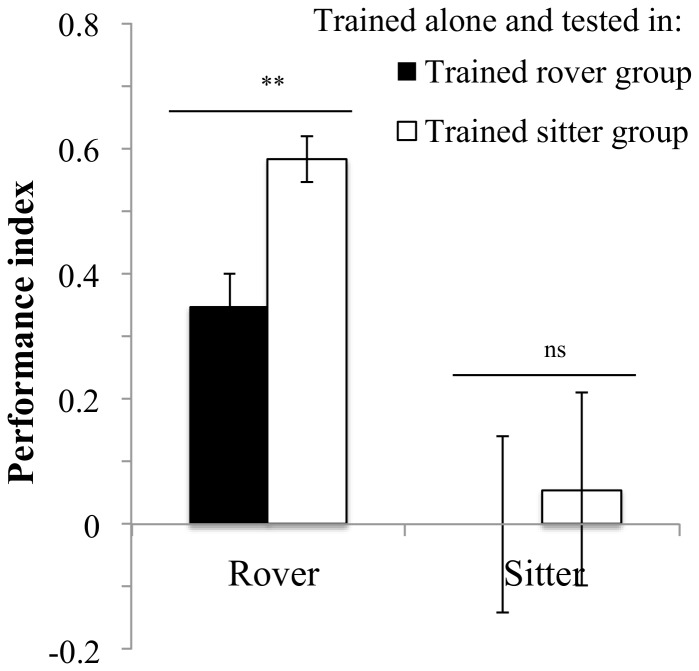
Effects of group composition during testing.Flies were individually trained and then tested within a trained group of the same strain or a different strain. Rover: in rover: PI = 0.34±0.05 N = 7 PI; in sitter: PI = 0.58±0.03 N = 6 PI. Sitter: in sitter: PI = 0.05±0.15 N = 6 PI; in rover: PI = 0±0.14 N = 7 PI. Error bars represent ±SEM. Comparison between treatments. ns: P>0.05; *: P<0.05; **: P<0.01; ***: P<0.001.